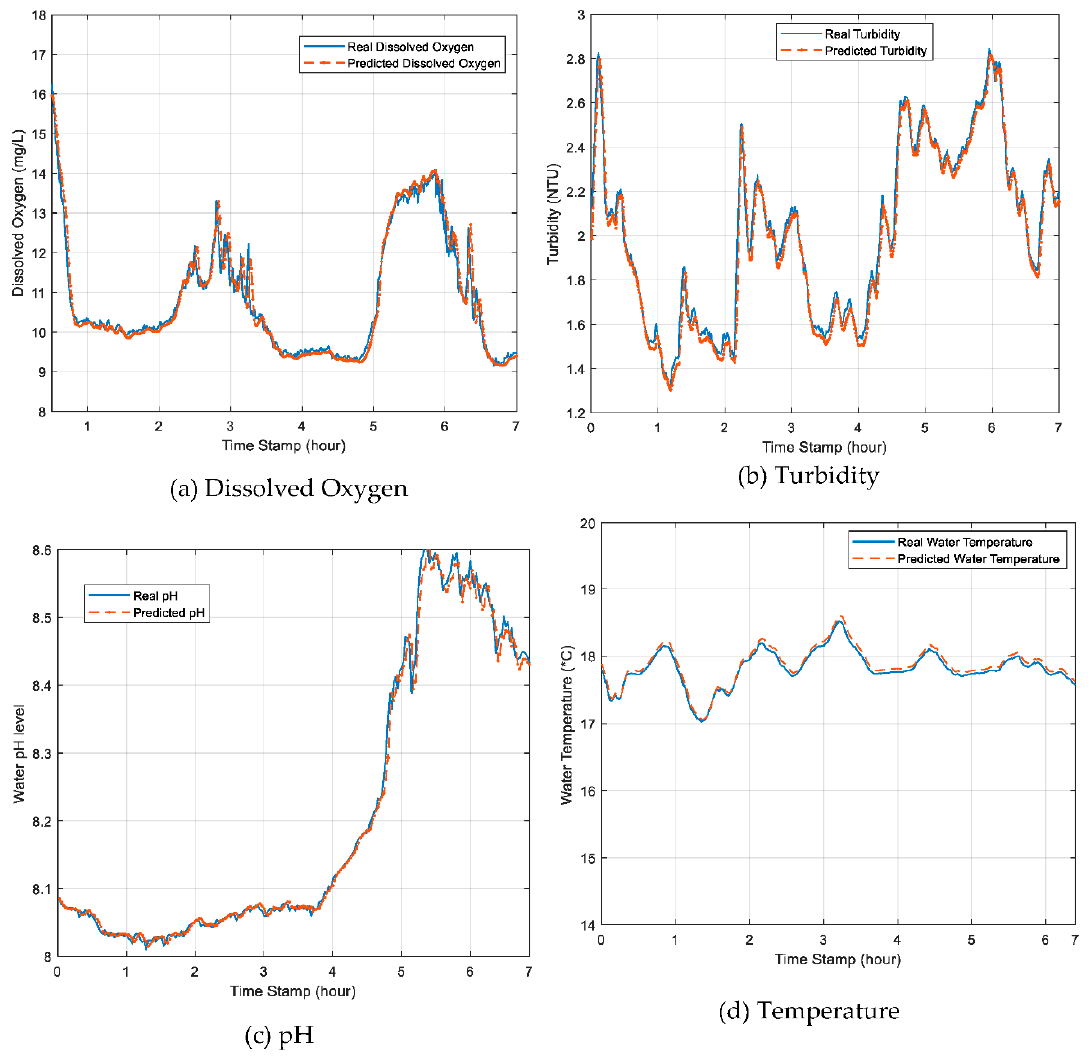
Figure 11. Comparison of real water quality parameters values and the predicted values: ( a ) dissolved oxygen, ( b ) turbidity, ( c ) pH, and ( d ) temperature. Table 2. Comparison of prediction accuracy for individual water quality parameters against a similar model x . Not appli- cable (NA) is used in this table because the reference model [2] did not include error statistics for DO and turbidity in their